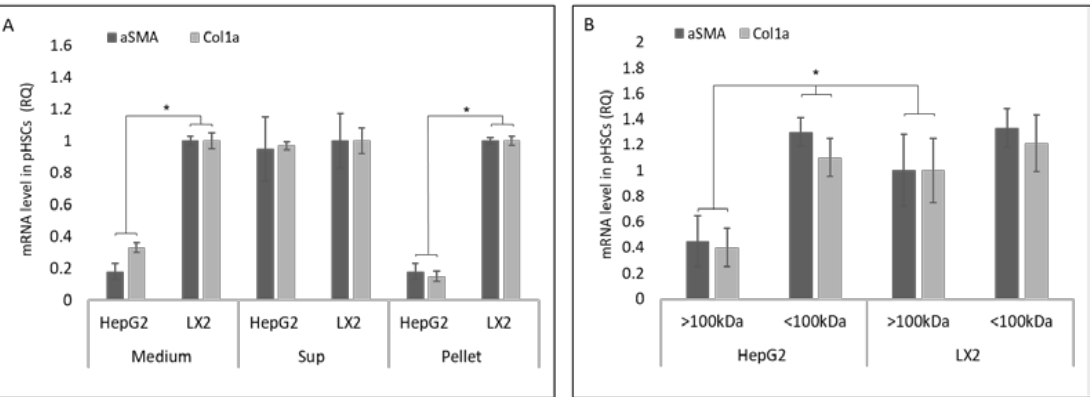
Figure 2. Effect of LX2 and HepG2-primed medium fractions on HSC differentiations markers. HepG2 and LX2 cells were cultured for 5 days. The primed medium was collected and separated into supernatant (Sup) pellet fractions or filtered through a cellulose membrane with a cutoff of 100 kDa (Section 2.2). pHSCs were incubated for 24 h with the supernatant, pellet, or the separated fractions containing >100 kDa or <100 kDa particles. ( A ) The effect of fractions of primed medium on αSMA and Col1a mRNA levels in pHSCs. ( B ) The effect of primed medium containing >100 kDa or <100 kDa particles on αSMA and Col1a mRNA levels in pHSCs. * Significantly lower than HepG2 cells or HepG2 >100 kDa, p < 0.05. ANOVA with a post-hoc Bonferroni-adjusted Student’s t -test.